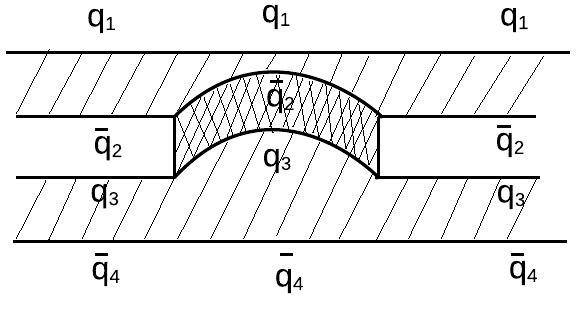
( q 1 ¯ q 4 ) + (¯ q 2 q 3 ) via recoupling of the ↔